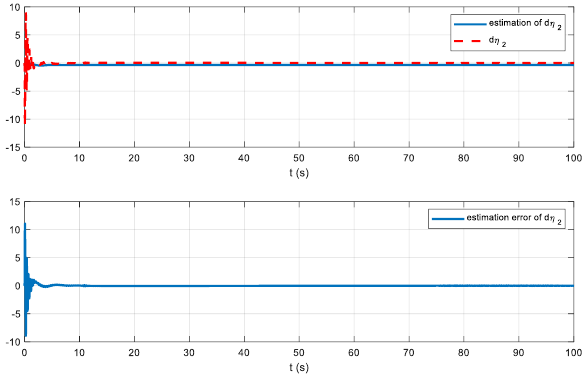
. Figure 7. η and its 2 Figure 7. 2  and its estimation.